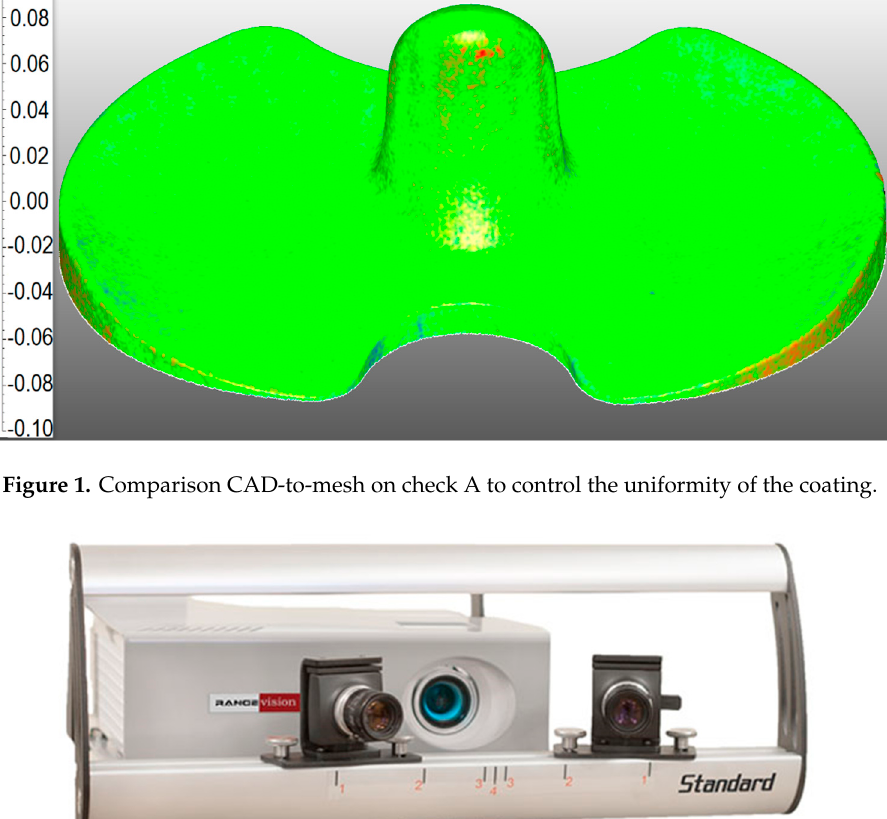
Figure 2. Three-dimensional digitizing instrument—Rangevision Professional Standard.